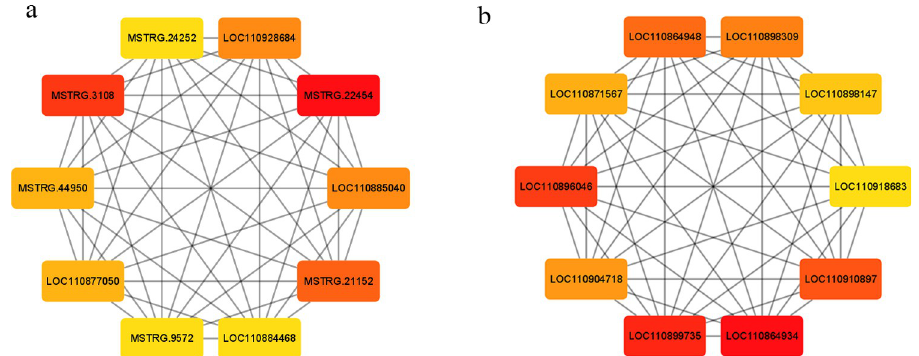
Fig 11. The top 10 genes in each module are calculated by MCC algorithm of cytohubba. (a)Top 10 genes in blue 4 module. (b)Top 10 genes in lightlateblue module.